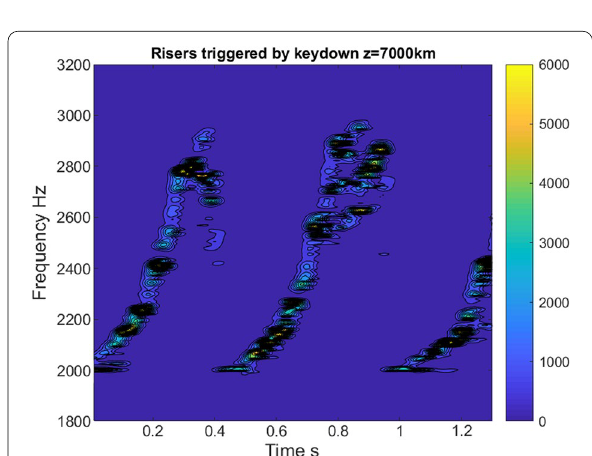
Fig. 3 Strong risers with separation 500 ms triggered by a CW key down signal of magnitude 7pT. Note the downward hook on riser 1 and bifurcation on riser